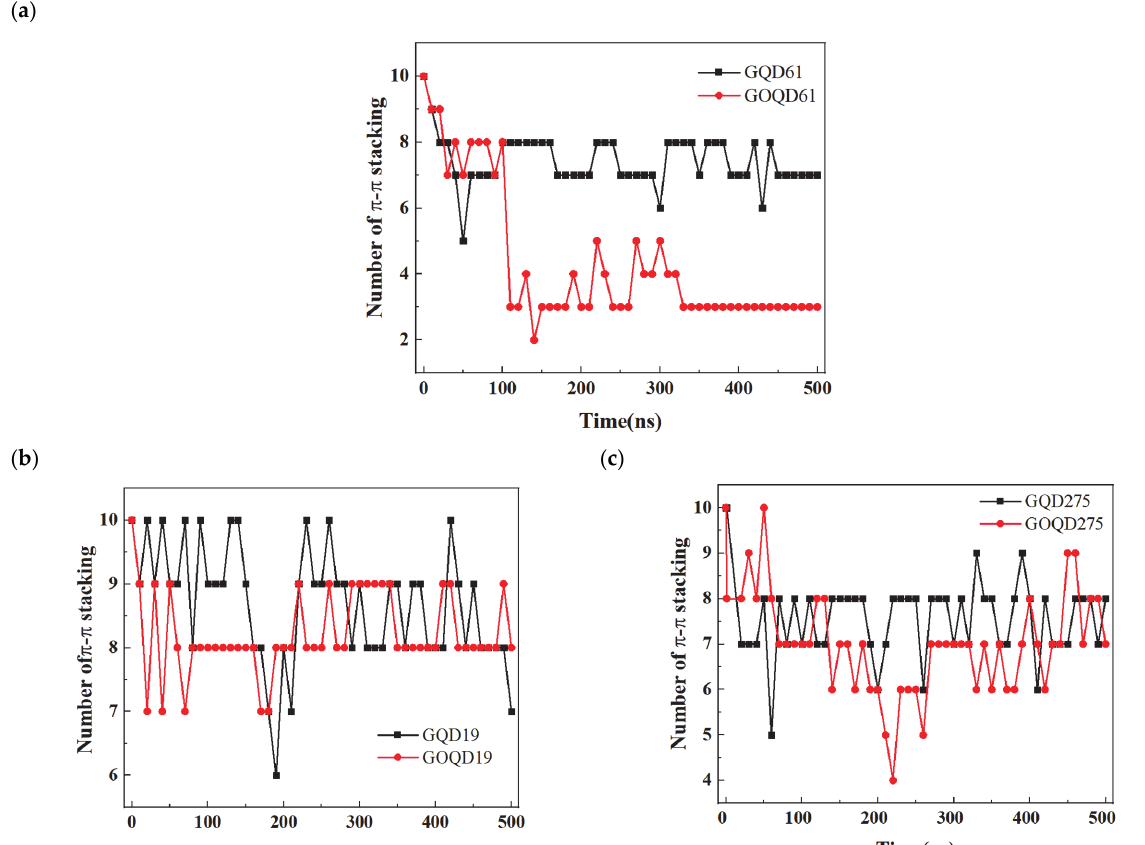
Figure 7. The π – π stacking number between dsDNA and GQD/GOQD with different sizes during the simulation: ( a ) GQD/GOQD 61; ( b ) GQD/GOQD 19; ( c ) GQD/GOQD 275.